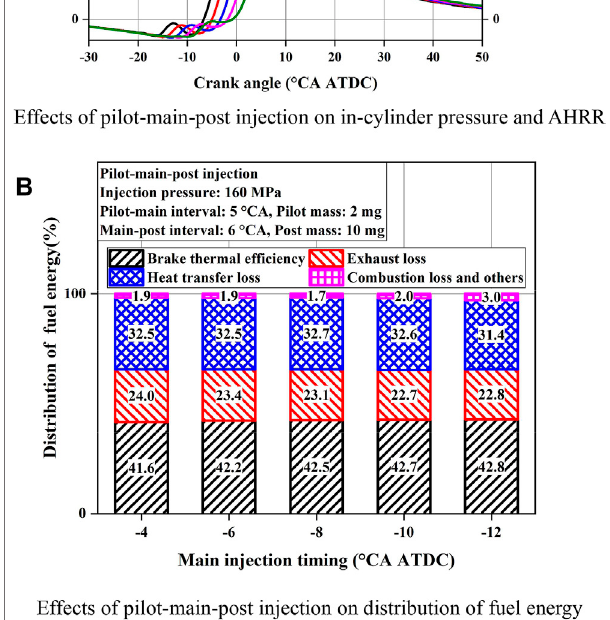
FIGURE 11 | Effects of pilot-main-post injection on combustion and emissions. (A) Effects of pilot-main-post injection on in-cylinder pressure and AHRR, (B) Effectsofpilot-main-postinjectionondistributionoffuelenergy. (C) Effects of pilot-main-post injection on emissions.